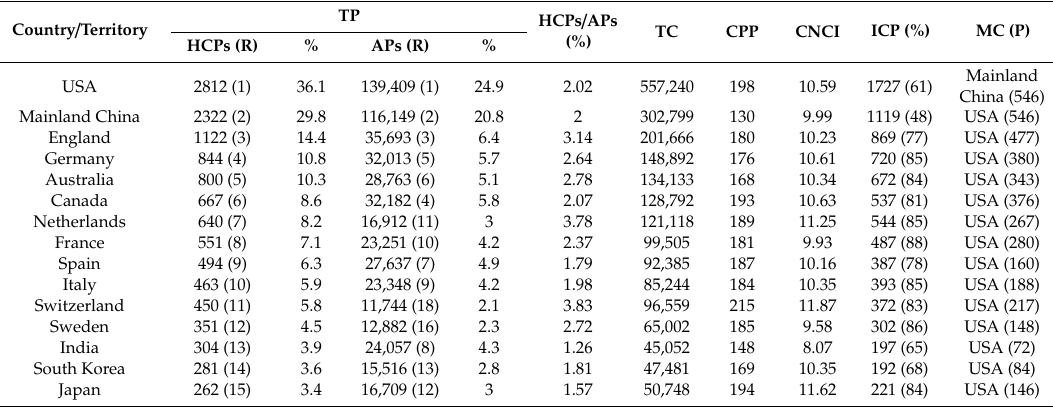
Table 2. Characteristics of the top 15 productive countries /